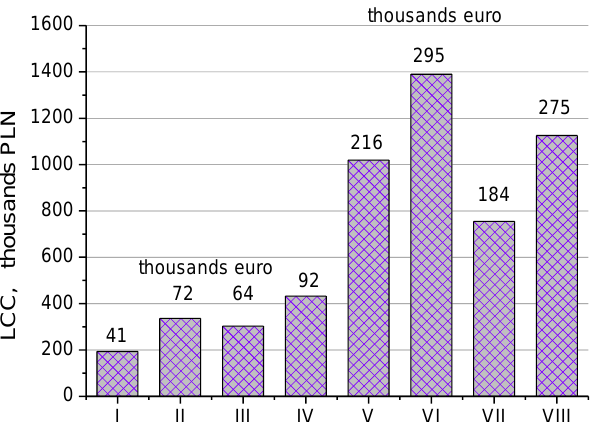
Figure 6. Life-cycle costing in thousands PLN (and in thousands EUR) for each option analyzed (methods I to VIII according to Table 1).